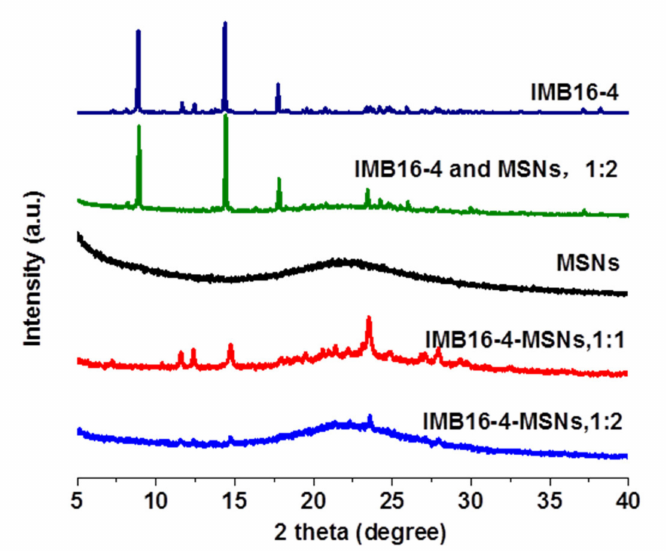
Figure 5. XRD patterns of MSNs, physical mixture and